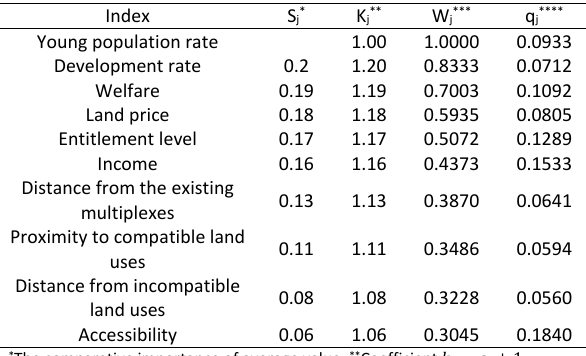
Table 4: Final results of SWARA Method in weighting indices